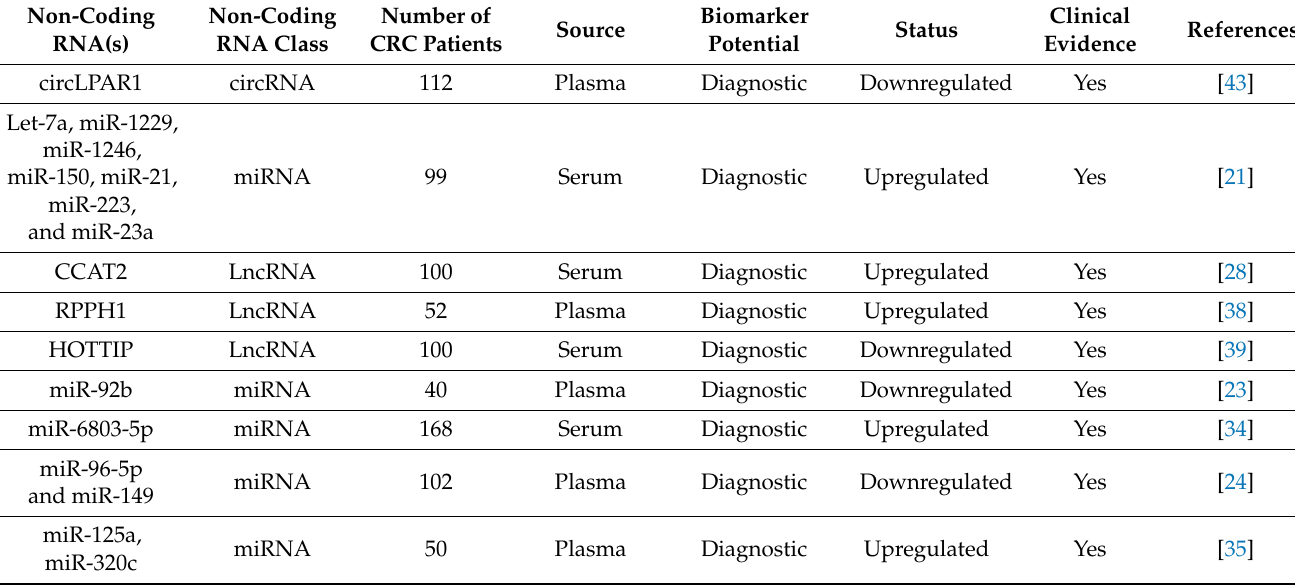
Table 1. Diagnostic biomarker potential of exosomal ncRNAs in